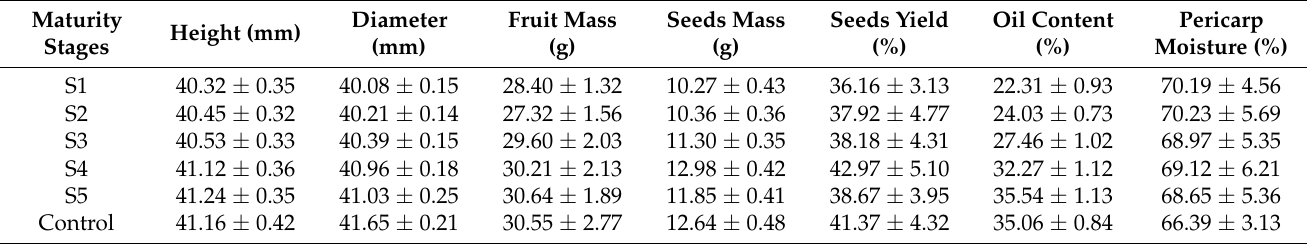
Table 1. Statistical results of the mean values and standard deviation (SD) for the physicochemical properties ( n = 10).